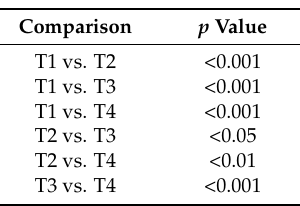
Table 2. Integrin expression Dunn’s multiple comparison between groups.